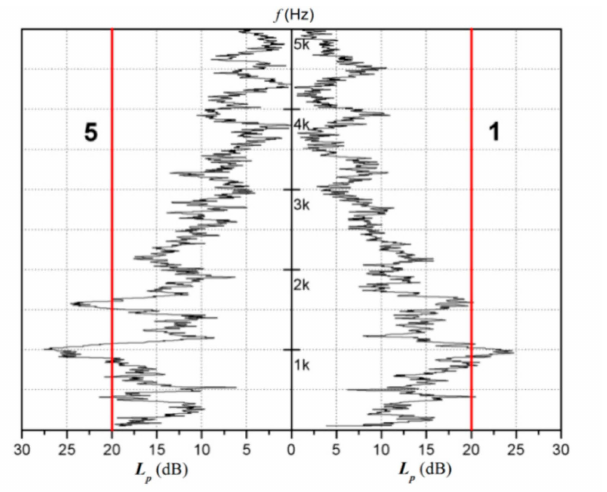
Figure 10. Frequency–spectrum comparison of measuring points 1 and 5 of the outlet at B-0.132 m 3 /s and 1000